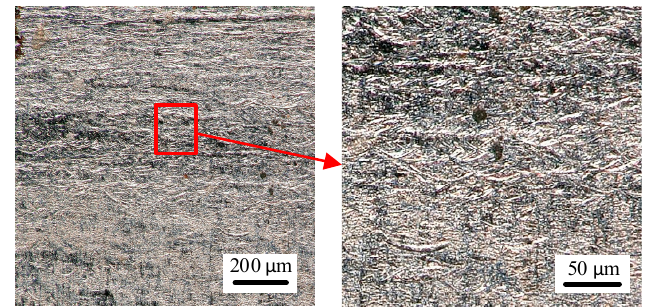
Figure 8. Surface morphology of tooth wall.